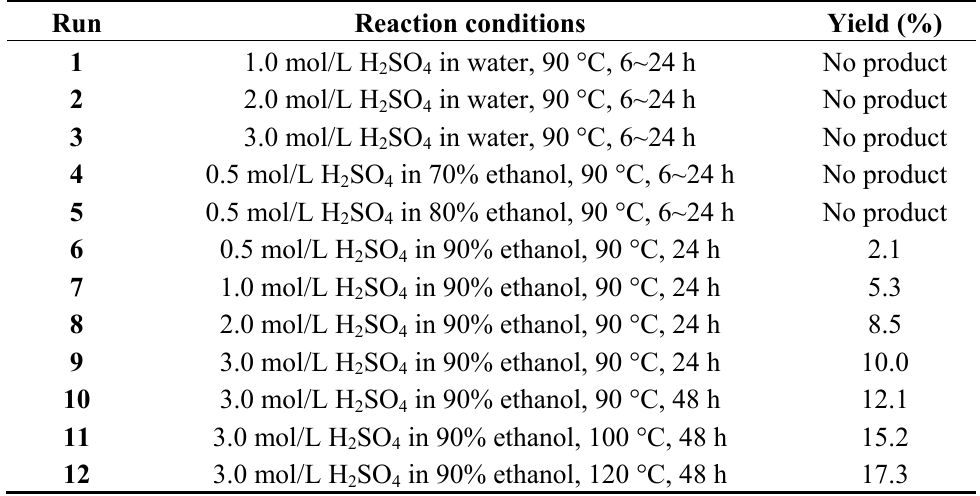
Table 1. Optimization of reaction conditions in the synthesis of scutellarein by hydrolyzing scutellarin. Run